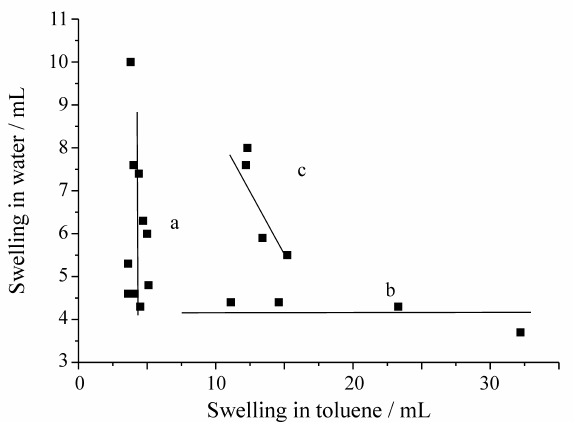
Figure 1. Swelling in water and in toluene media of the original mont- morillonites and organo-montmorillonites.